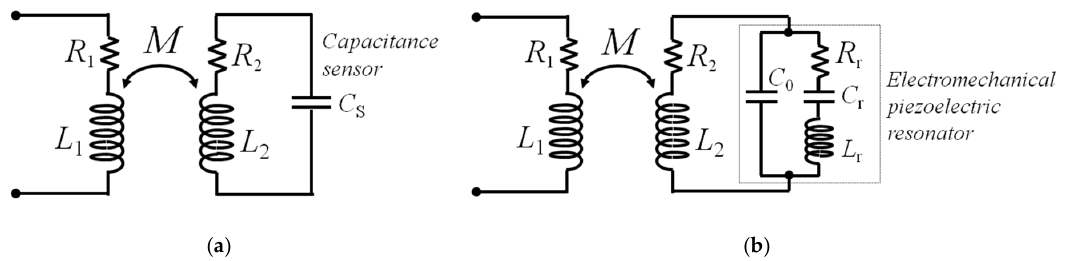
Figure 2. Equivalent circuits of the two considered cases for a coil-coupled resonant sensor unit (RSU): ( a ) capacitance sensor C S ; ( b ) electromechanical piezoelectric resonator represented with its equivalent Butterworth–van Dyke (BVD) model.